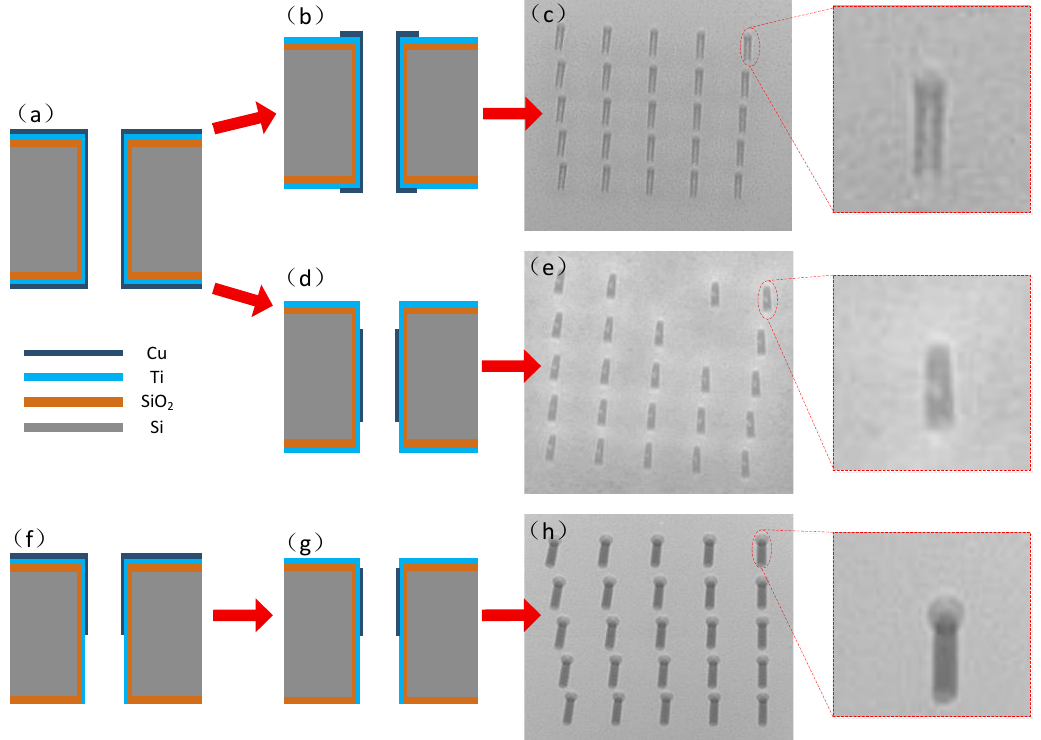
Figure 3. Schematic illustration and X-ray images of seed layer sputtering effect. ( a ) Double-side sputtering of TSV; ( b ) Double-side Cu-etched TSV with lithography; ( c ) X-ray image of electroplated sample ( b ); ( d ) Double-side Cu-etched TSV without lithography; ( e ) X-ray image of electroplated sample ( d ); ( f ) Single-side sputtering of TSV; ( g ) Single-side Cu-etched TSV without lithography; ( h ) X-ray image of electroplated sample ( g ).